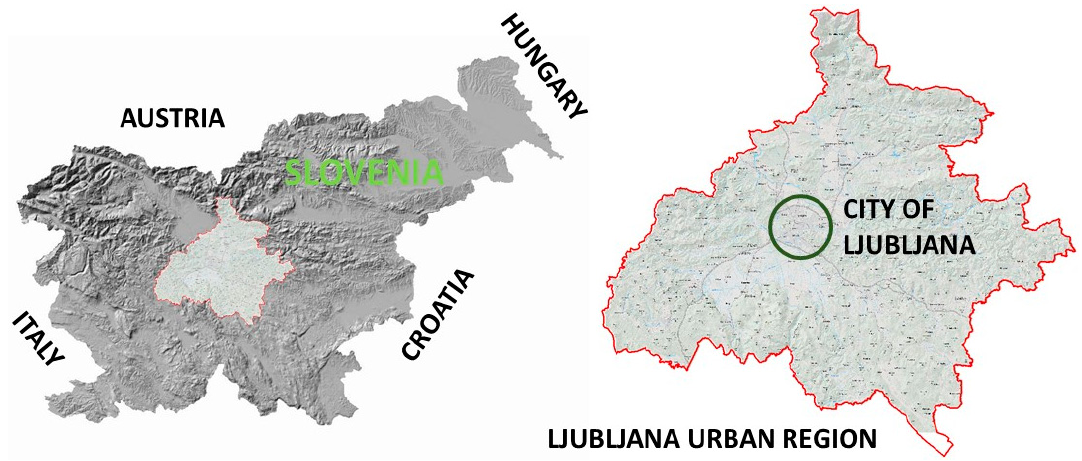
Figure 3. Ljubljana Use Case